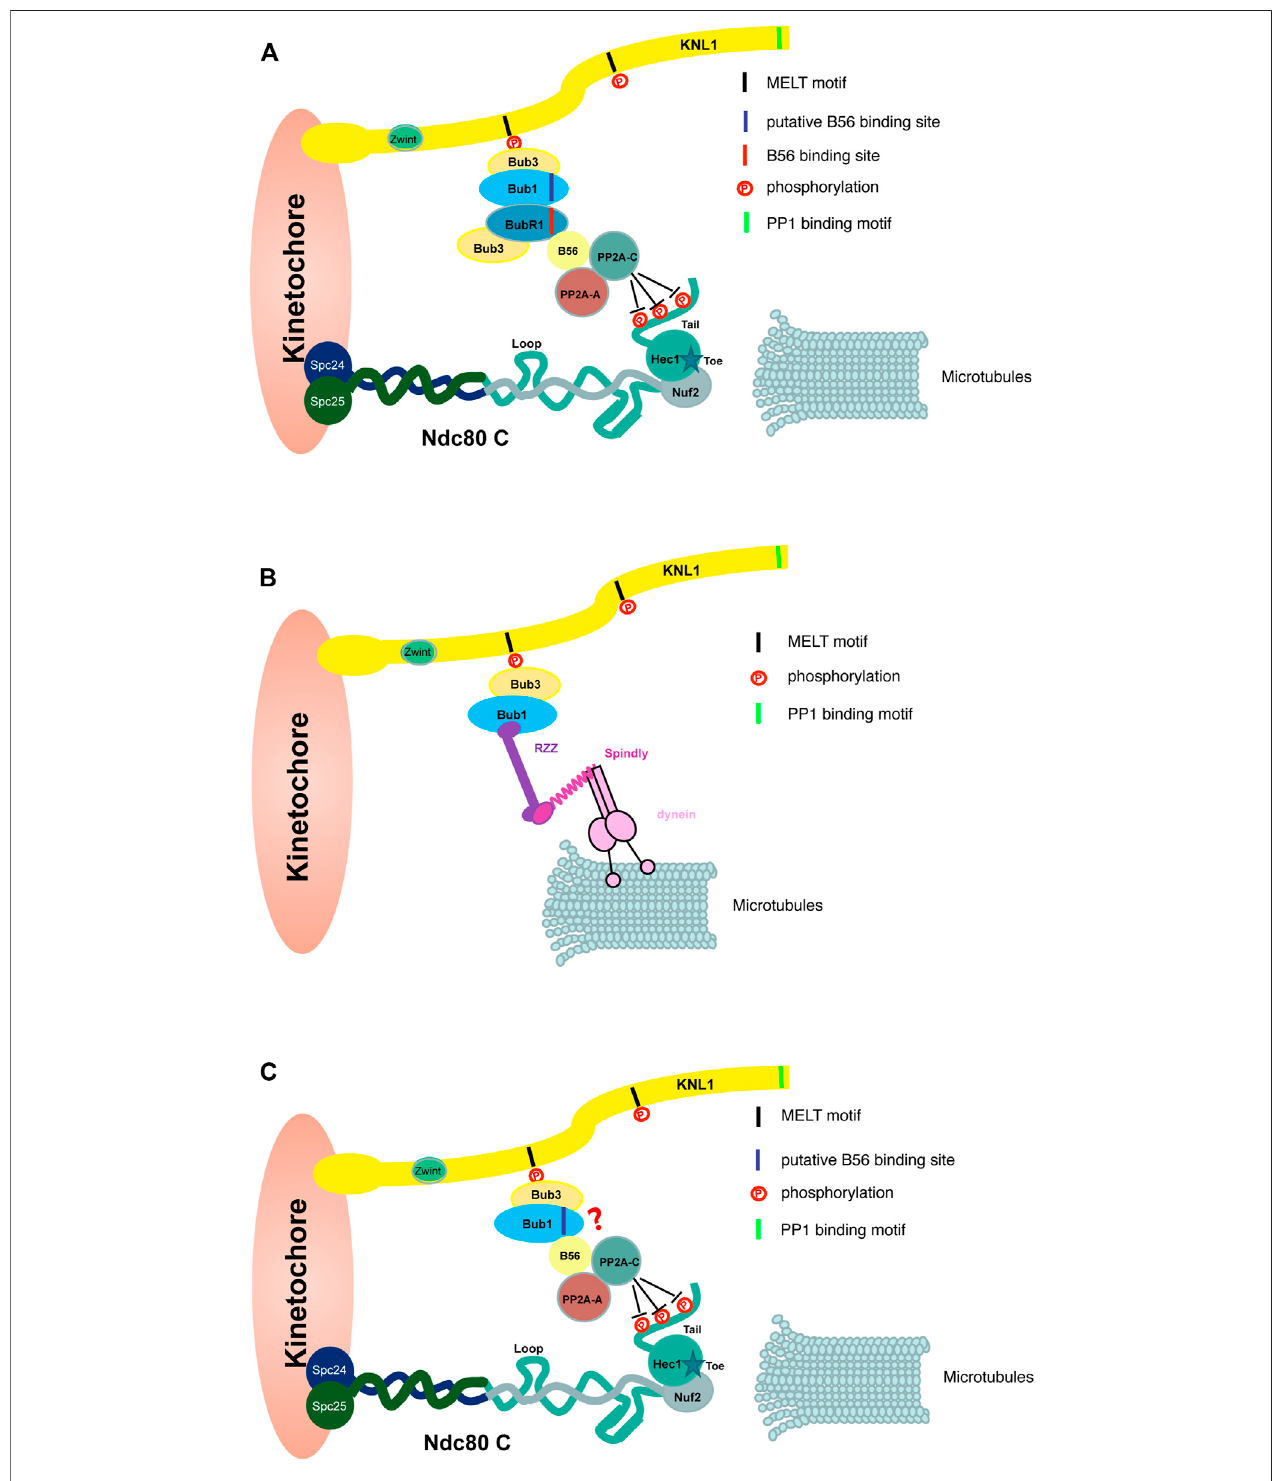
FIGURE 4 | Bub1 promotes kinetochore-microtubule attachment through multiple possible pathways. The cartoon shows Bub1 promotes kinetochore- microtubule attachment through a few possible pathways. (A) Bub1 interacts BubR1 directly and the latter brings protein phosphatase PP2A-B56 onto outer kinetochores. The PP2A-B56 complex dephosphorylates multiple outer kinetochore proteins like Ndc80 shown here, which stabilizes the attachment between kinetochores andmicrotubules. (B) Bub1promotes thekinetochore localizationofRZZcomplex.Throughaninteraction withdyneincomplexmediated bySpindly protein,Bub1-RZZmayfacilitatetheinitiallateralinteractionbetweenkinetochoresandmicrotubules.RZZ-Spindlyisabletooligomerizeintoa fi brouscoronawhichisnot shown here. (C) Bub1 may interact PP2A/B56 directly through the putative B56 binding motif. PP2A/B56 promotes a stable kinetochore-microtubule attachment as described in (A) The contribution of the kinase activity is not shown here.